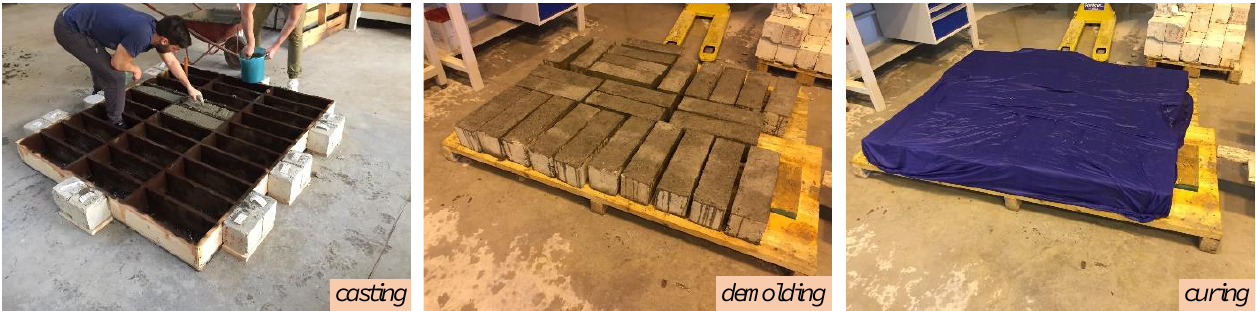
Figure 2. Preparation phases of concrete beams.